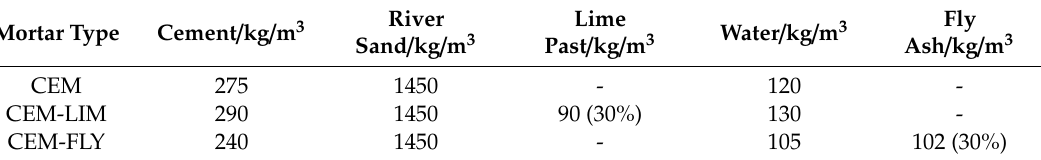
Table 4. Mix ratio of